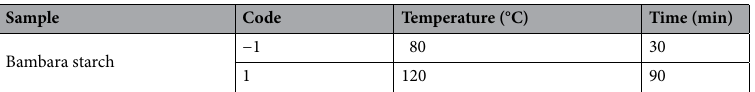
Table 1. Levels of independent variables used for central composite rotatable